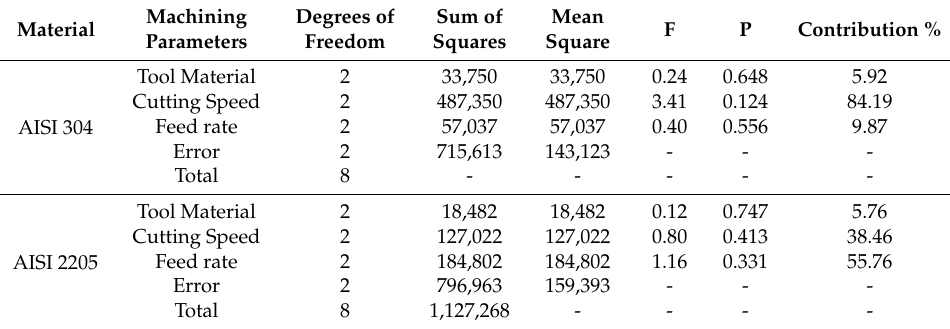
Table 9. Results of analysis of variance (ANOVA) for cutting force.